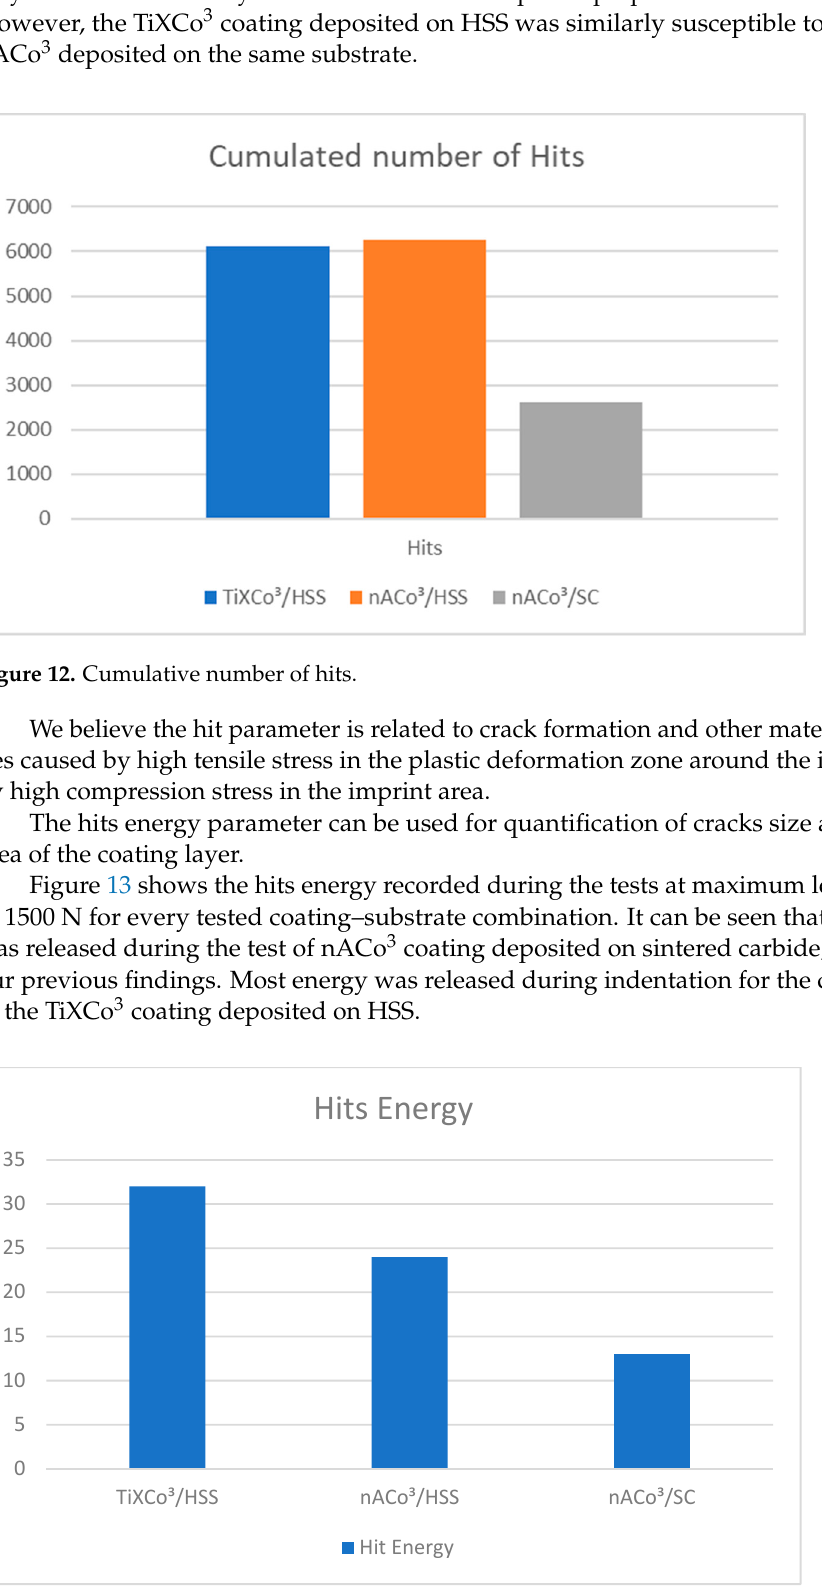
Figure 13. Maximum hits energy reached at F max = 1500 N.